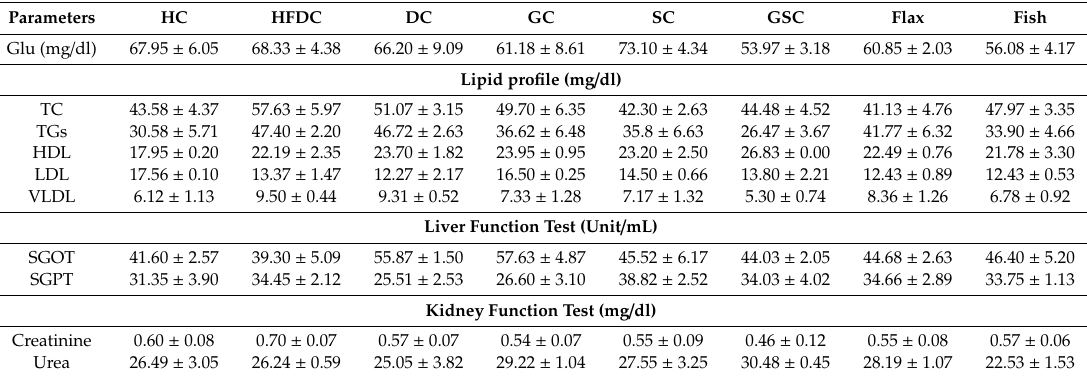
Table 5. Biochemical assessment before initiation of HFD.